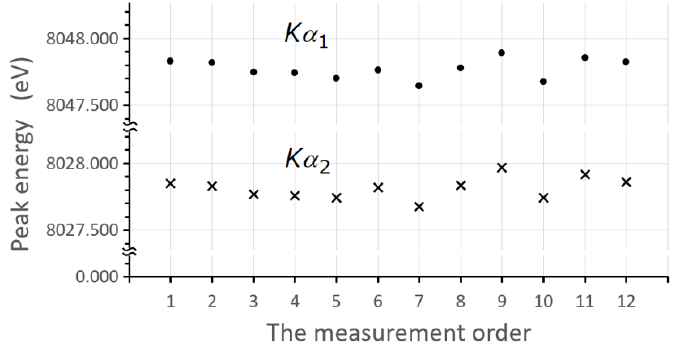
Figure 5. Peak position of the Cu K α 1,2 lines due to asymmetry fitting in different measurements. For each measurement, a sample of 3 d elements was measured. The variation of the peak position is very small. The K β / K α intensity ratio of each element seems to be hardly affected by the variation of the instrument. For details, see the